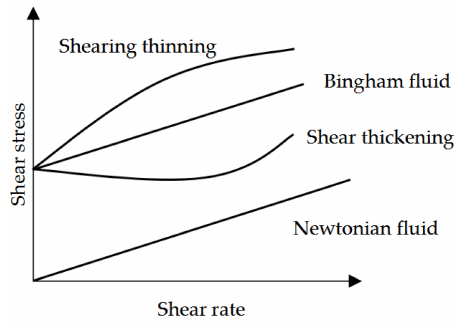
Figure 3. Several typical fluidity curves